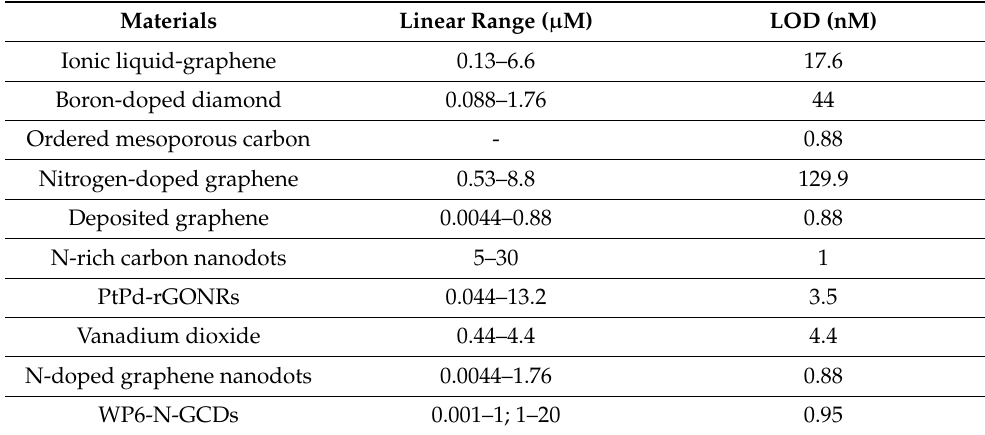
Table 6. Comparison of some electrode materials for electrochemical sensing of TNT [41].